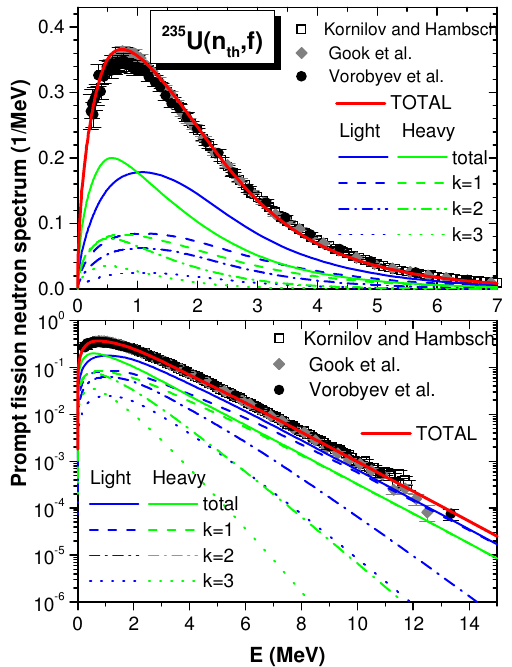
Fig.4 : PFNS result of the LA model with sequential emission: spectra of each emitted neutron (different dashed or dotted lines) and of all emitted neutrons (thin solid lines) from the light (blue colour) and heavy (green colour) fragments and the total spectrum (thick solid red line) describing well the experimental data (different